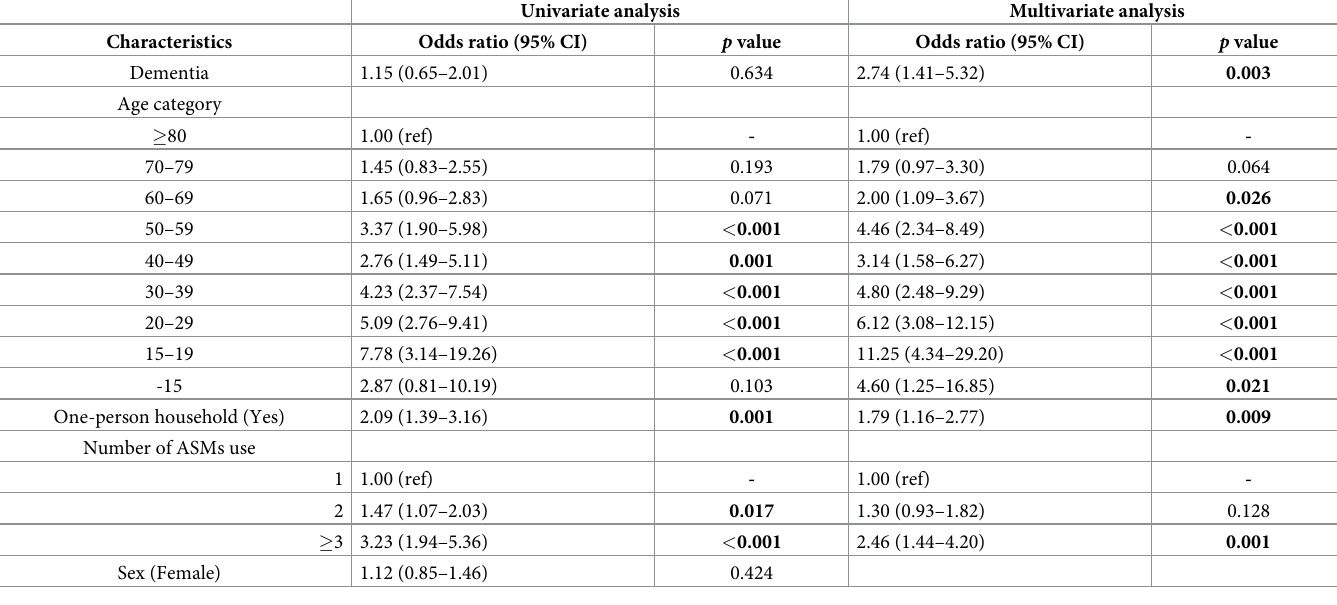
Table 4. The univariate and multivariate logistic regression analyses associated with forgetting to take ASMs using the response to Q1 on the Morisky Medication Adherence Scale questions as the dependent variable. Univariate analysis Multivariate